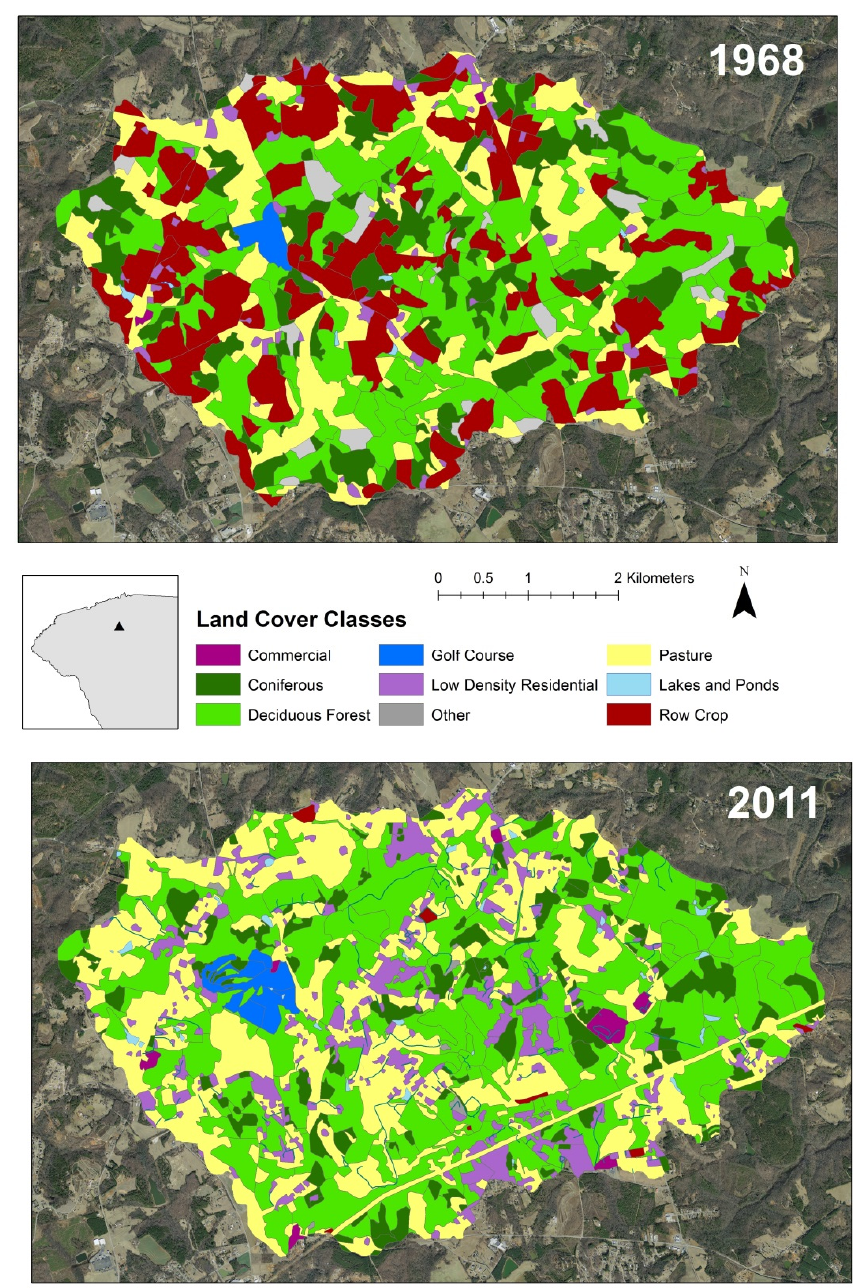
Figure 4. Land cover classification for Doddies Creek watershed in 1968 and